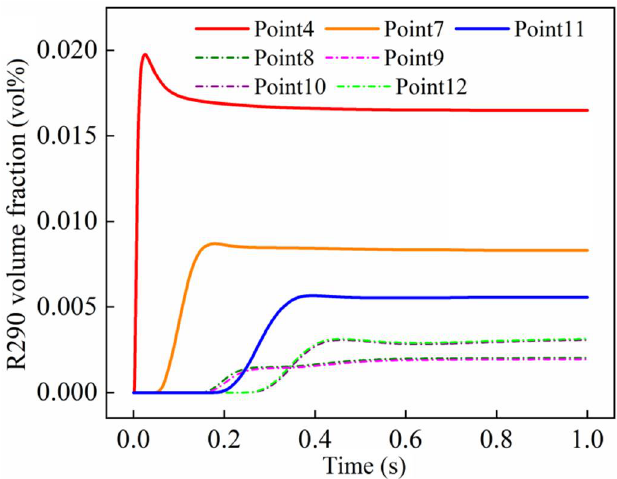
Figure 9. Changes in the R290 concentration at different locations in space over time.